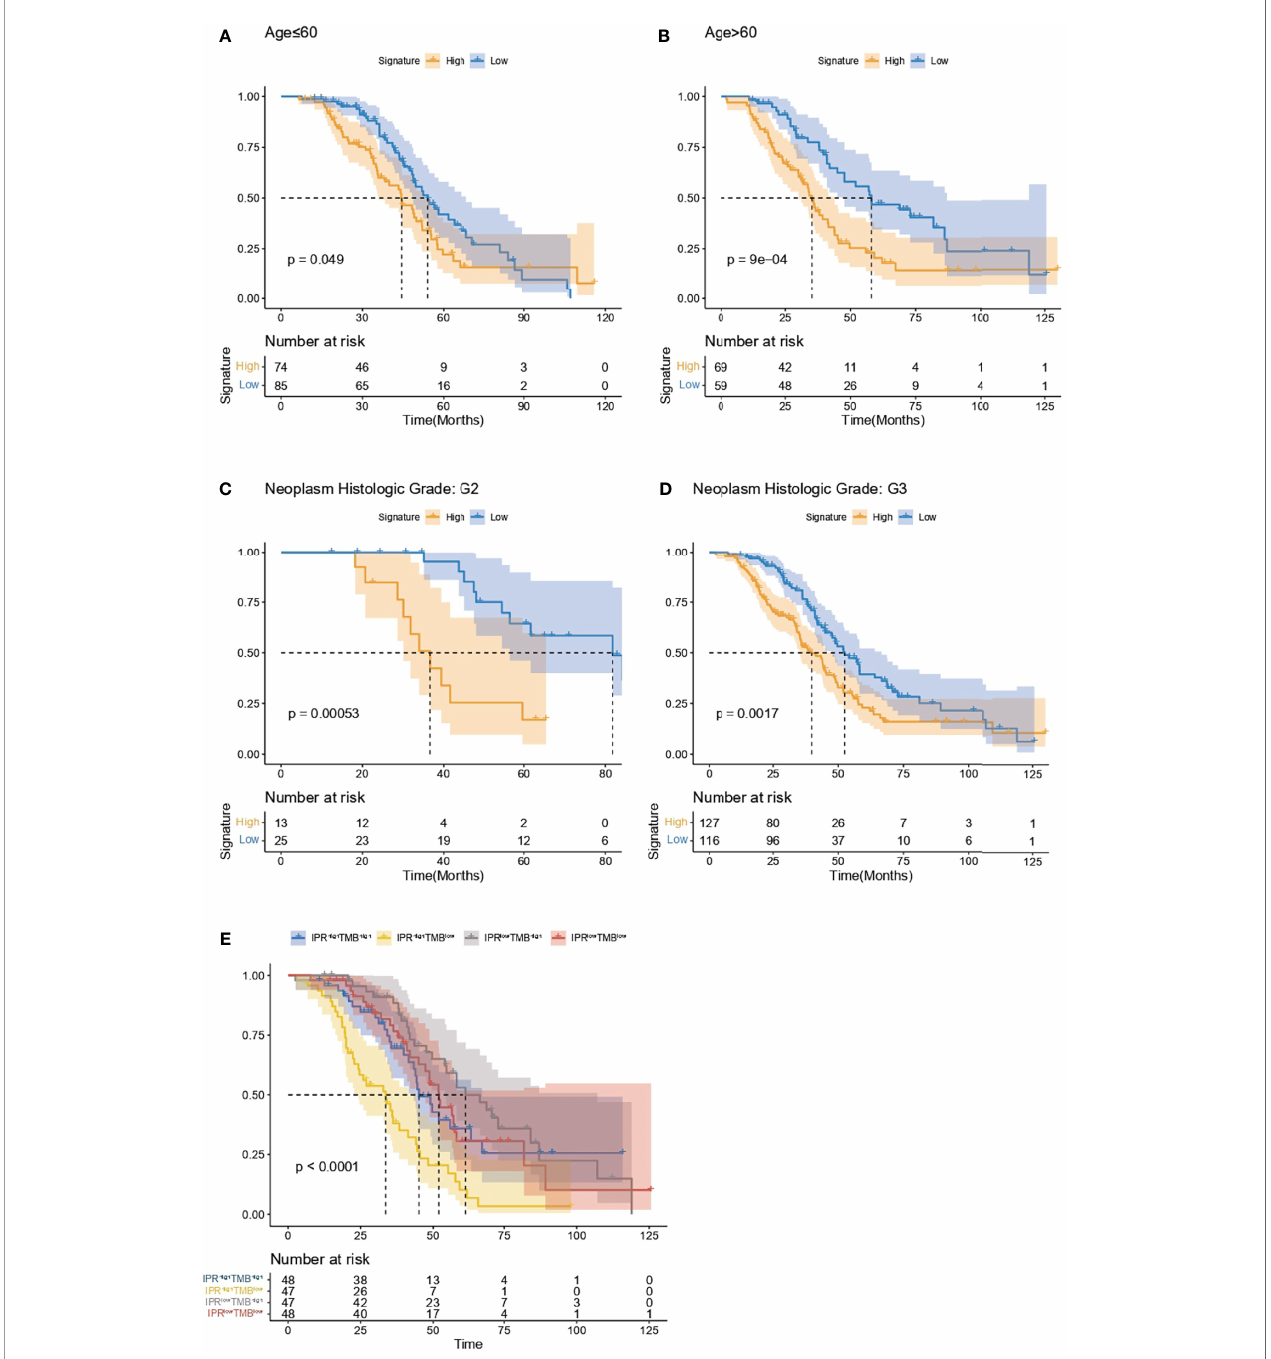
FIGURE 7 | Analysis of the survival prediction of IPR signature in patients with different clinical feature. Kaplan – Meier analysis of the overall survival of patients diagnosed below (A) and beyond 60 years old (B) , neoplasm histological grade of G2 (C) and G3 (D) . (E) Kaplan – Meier analysis of the overall survival on the strati fi cation of mutation burden and IPR